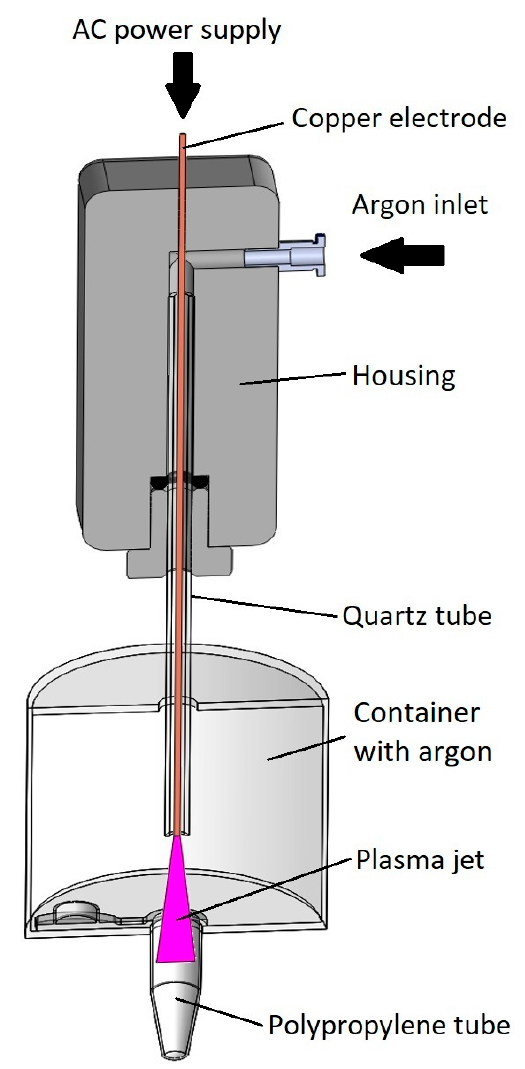
Figure 1. Schematics of gaseous plasma treatment of tube inside a container in cross-section view.